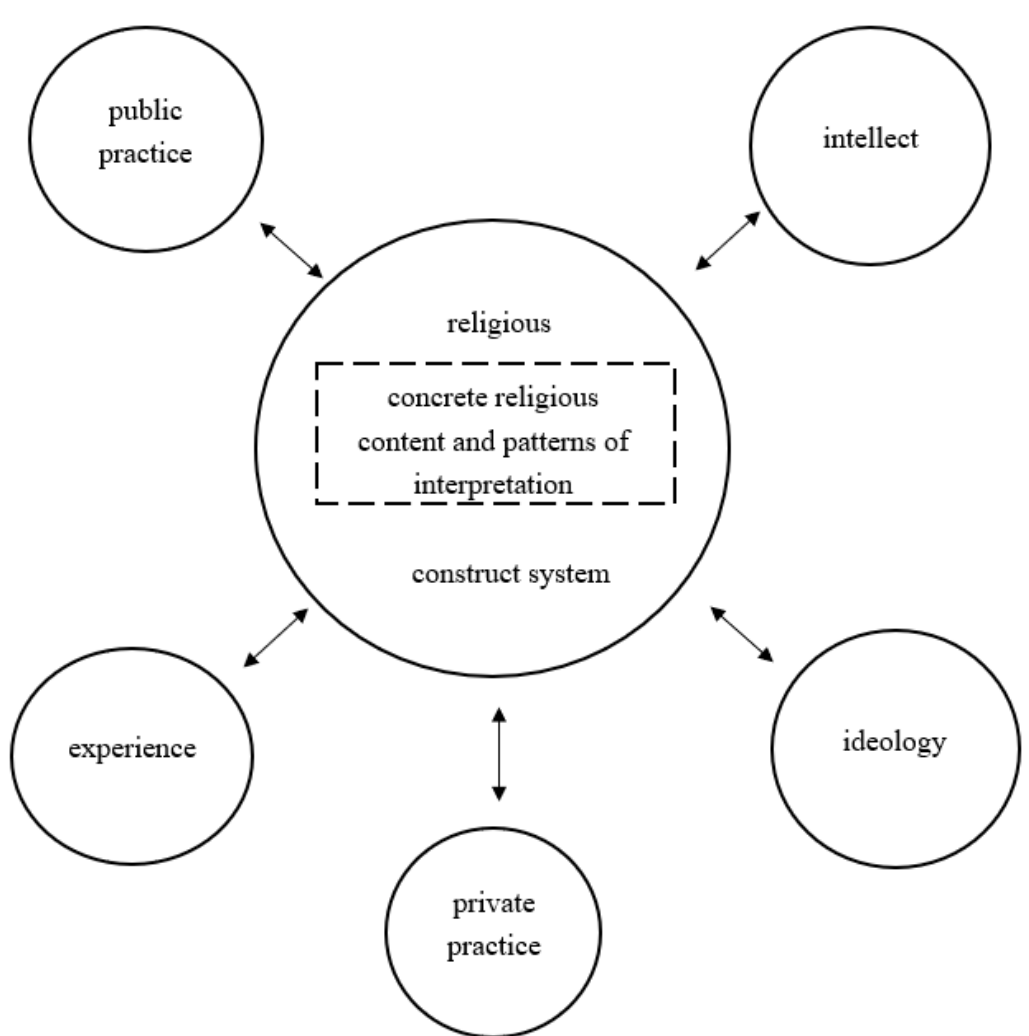
Figure 1. The model of religiosity by Huber. Based on Religiosität: Messverfahren und Studien zu Gesundheit und Lebensbewältigung (p. 88) by C. Zwingmann & H. Moosbrugger (Eds.), 2004, Münster: Waxmann. © by Waxmann.